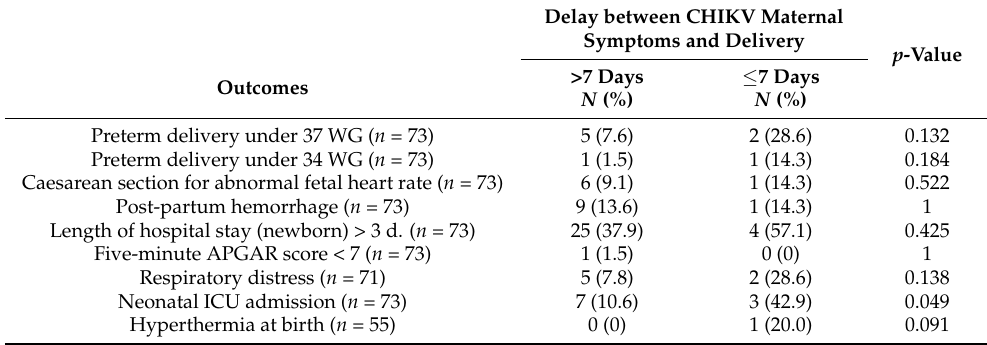
Table 5. Frequency and comparison of pathological events in the CHIKV group according to time from maternal CHIKV symptoms to delivery (pregCHIKV study 2022 N =